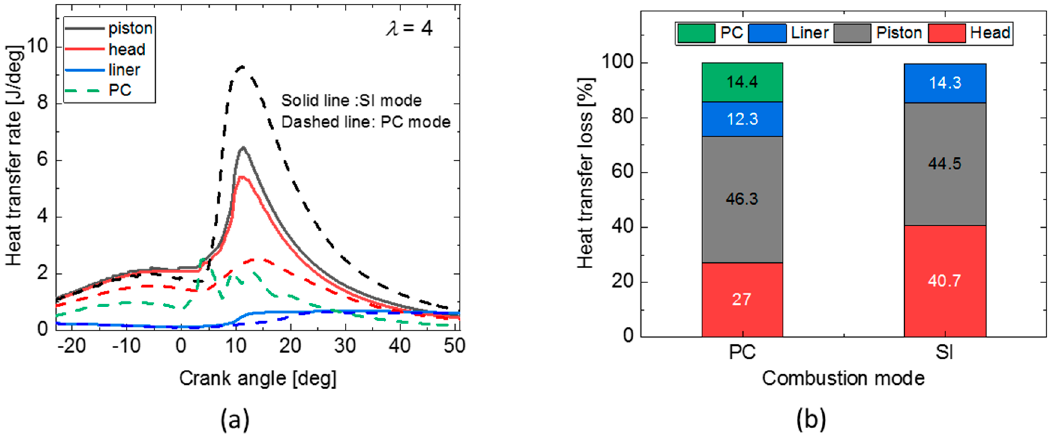
Figure 21. Comparison of the predicted: ( a ) heat transfer rates traces; and ( b ) % of heat transfer loss for SI mode (CR = 14.5 and ST = − 8°) and passive PC mode (CR = 14 and ST = − 3°) using λ = 4.